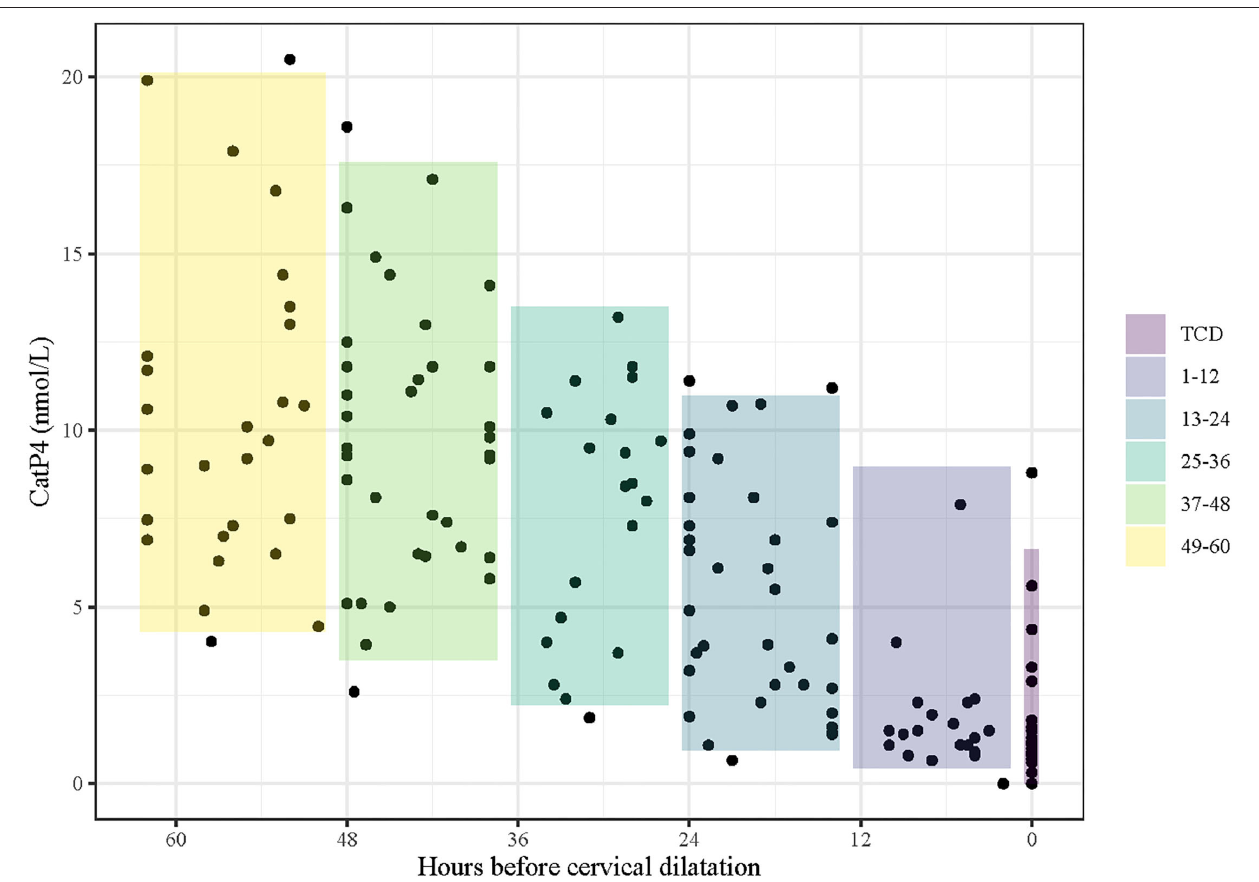
FIGURE 5 | Serum progesterone levels determined with the point-of-care Catalyst assay (CatP4) at regular times every day (08h00 and 18h00) and at the time of cervical dilatation (TCD; Time 0) in 28 bitches. The data are aligned to TCD level. Shaded boxes indicate estimated distribution, determined using 100,000 bootstrapped samples and reference interval statistics to infer levels for the central 95% of a larger population similar to the study